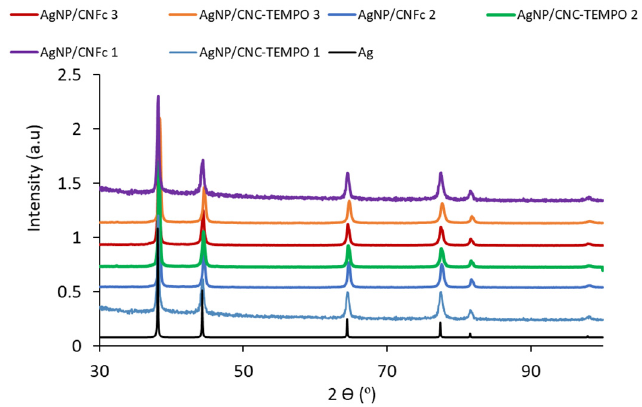
Figure 5. XRD patterns of as-synthetized Ag NP/NC composites. FCC crystalline Ag pattern has been added for comparison purposes.